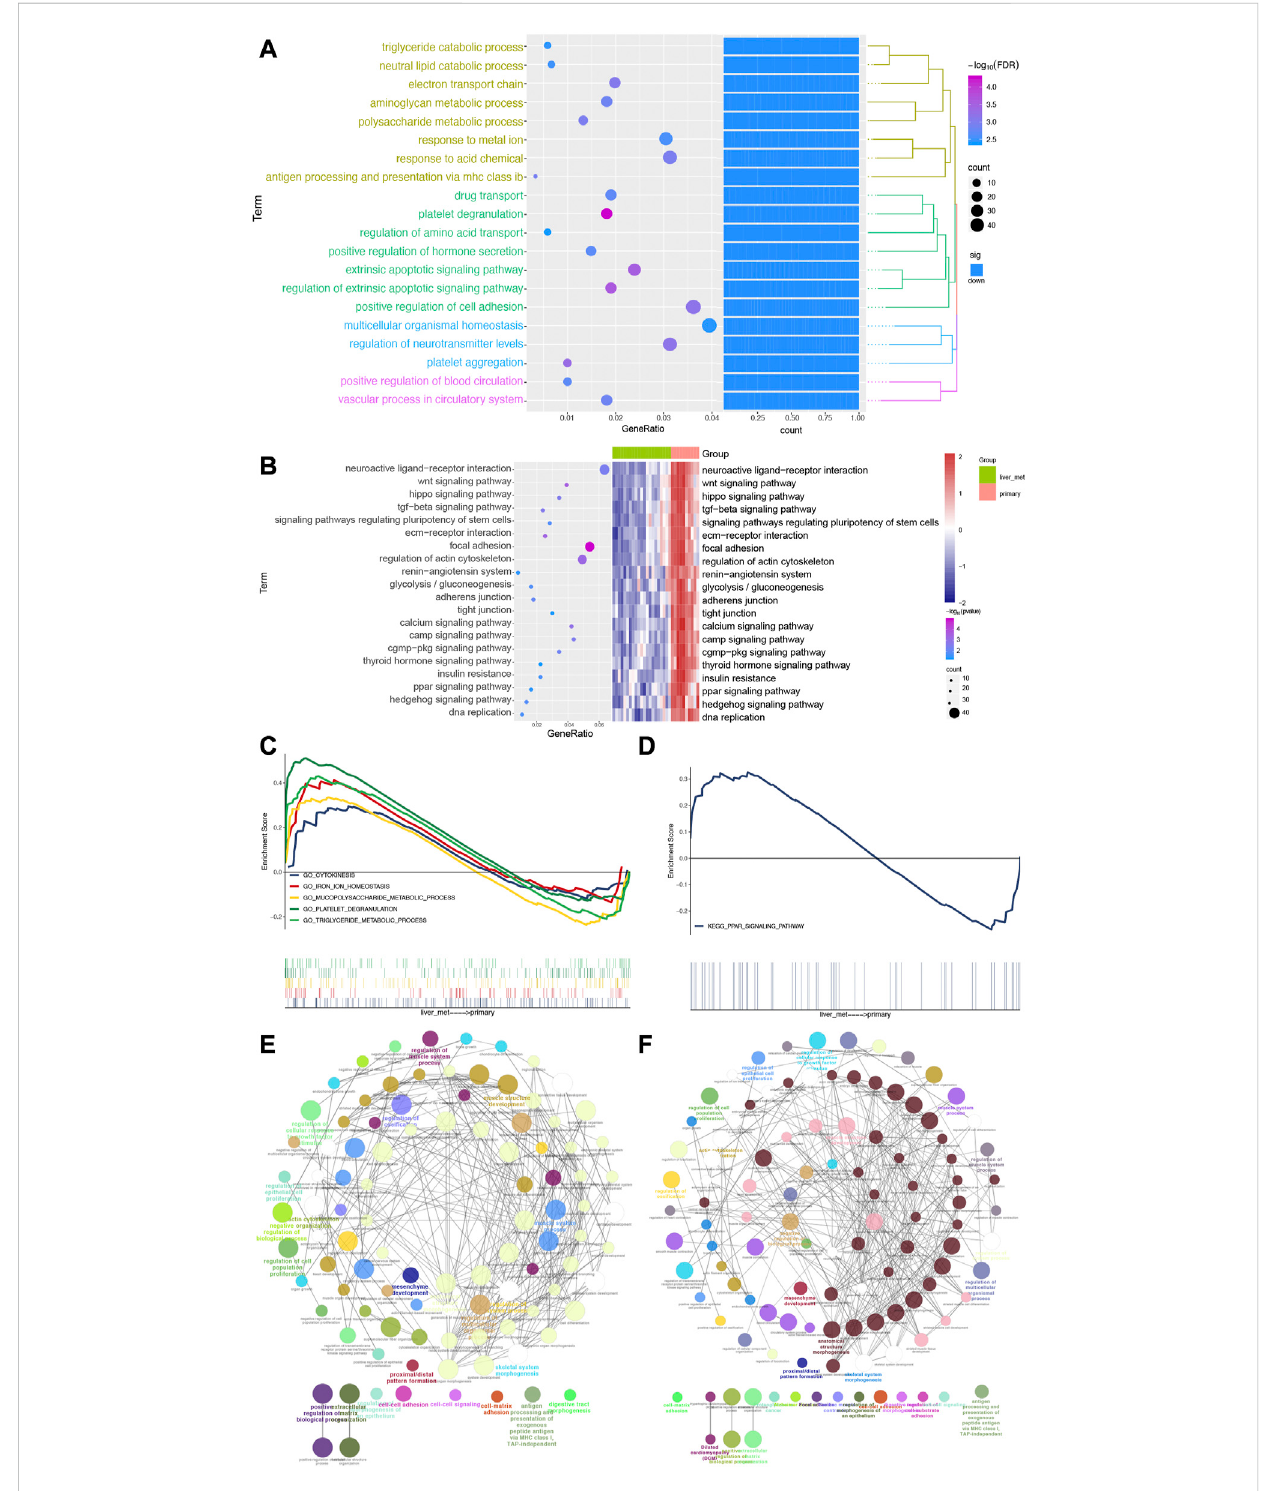
FIGURE 3 Biological processes and pathways of DEGs for patients with SI-NETs. (A) The top 20 biological processes for patients with SI-NETs. (B) The top 20 KEGG pathways for patients with SI-NETs. (C) GSEA results revealed the signi fi cantly enriched GO-BPs between patients with primary and metastatic SI-NETs. (D) GSEA results revealed the signi fi cantly enriched KEGG pathways between patients with primary and metastatic SI-NETs. (E) The ClueGo network for GO-BPs in patients with SI-NETs. (F) The ClueGO network for KEGG pathways in patients with SI-NETs. SI-NETs, small intestine neuroendocrine tumors; GSEA, gene set enrichment analysis; GO, gene ontology; BPs, biological processes; KEGG, Kyoto Encyclopedia of Genes and